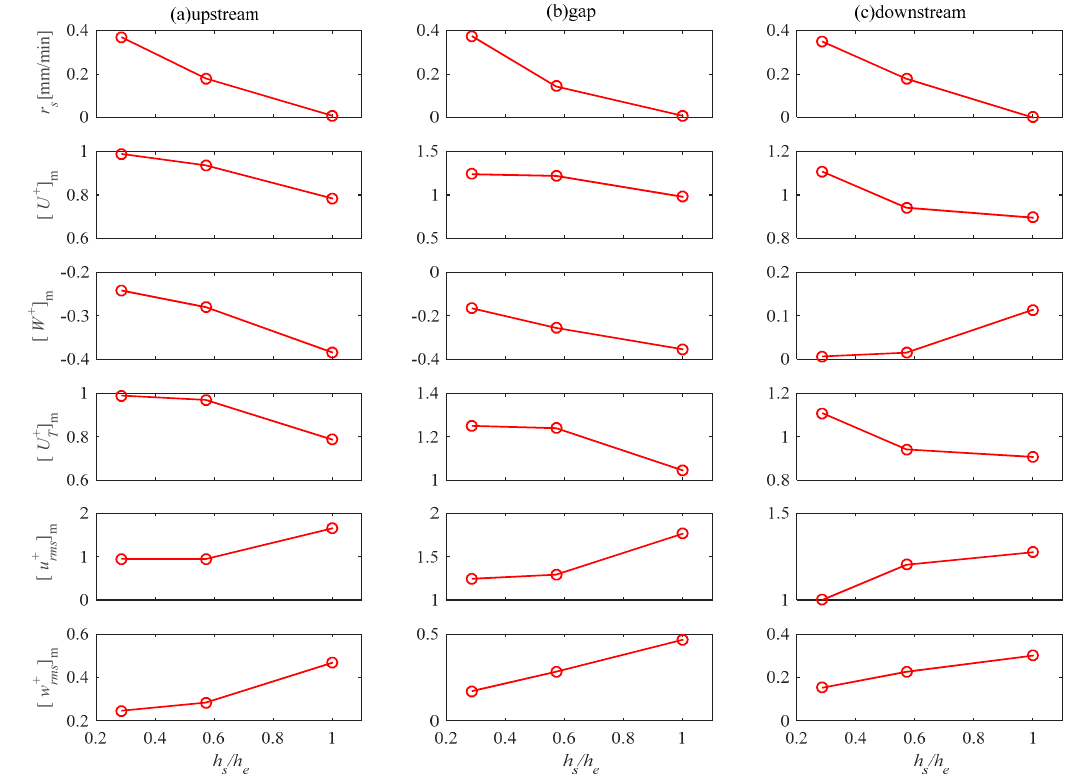
Figure 10. Variation of mean velocities and turbulent intensities with scour depth: ( a ) upstream, ( b ) gap, and ( c ) downstream.